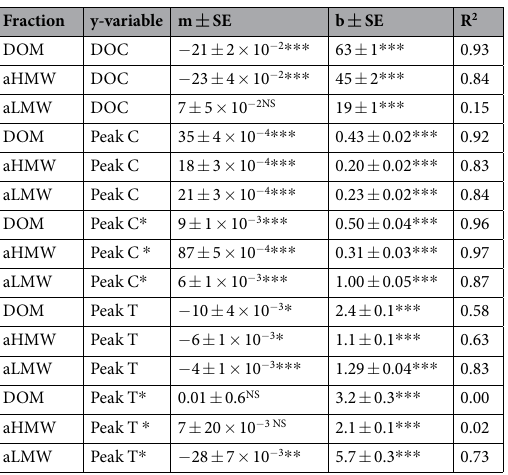
Table 1. Linear regressions (model II) between DOC and FDOM indices (y-variable) and apparent oxygen utilization (x-variable) obtained from bulk DOM and apparent HMW (aHMW) and LMW (aLMW) fractions from samples collected at the salinity maximum (LIW). n = 9, m = slope, b = intercept, SE = Standard error and NS = Non significant. * , ** , *** correspond with p < 0.05, p < 0.01 and p < 0.001, respectively. DOM < 0.7 µ m, aHMW < 0.7 µ m and > 1 kDa and aLMW < 1